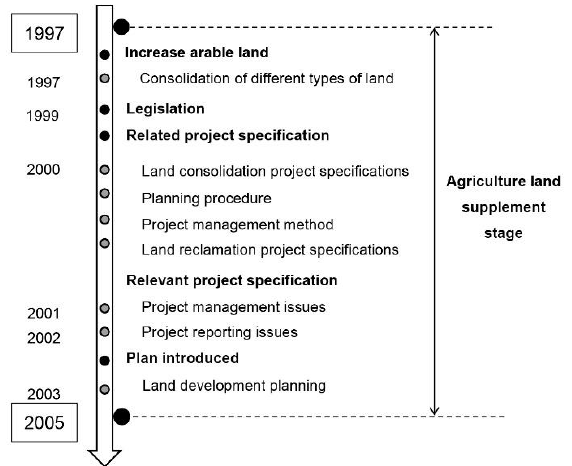
Figure 2. Schematic diagram showing development in the budding exploration stage.